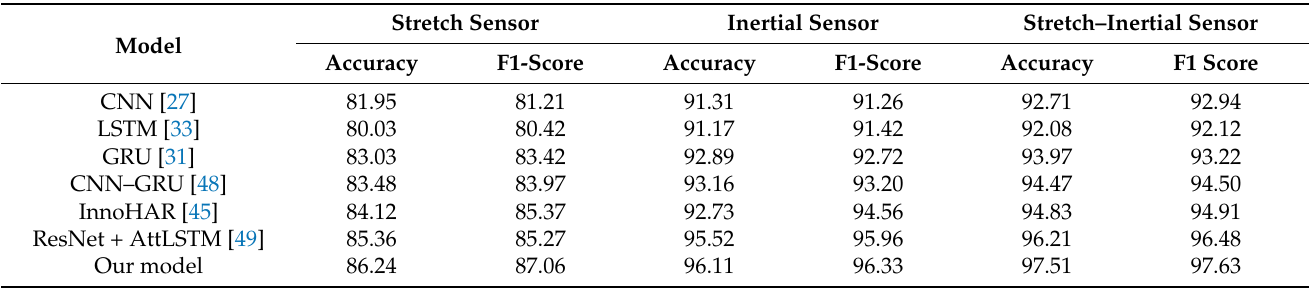
Table 7. Results of comparison between baseline models using the IS-Data